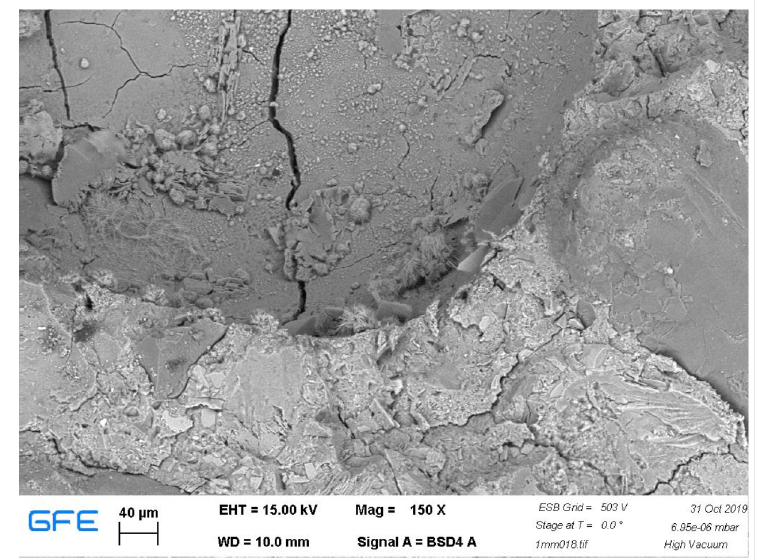
Figure 13. SEM micrograph (1 mm depth) of concrete with CEM III/A 42.5 N (w/c = 0.50) stored for 182 d at 5 ◦ C in Na 2 SO 4 solution with 6000 mg SO 42 − /L.